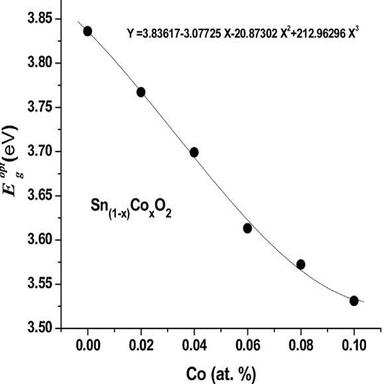
The optical bandgap Eg opt as a function of SnO2 nanoparticles doped with Co concentration.